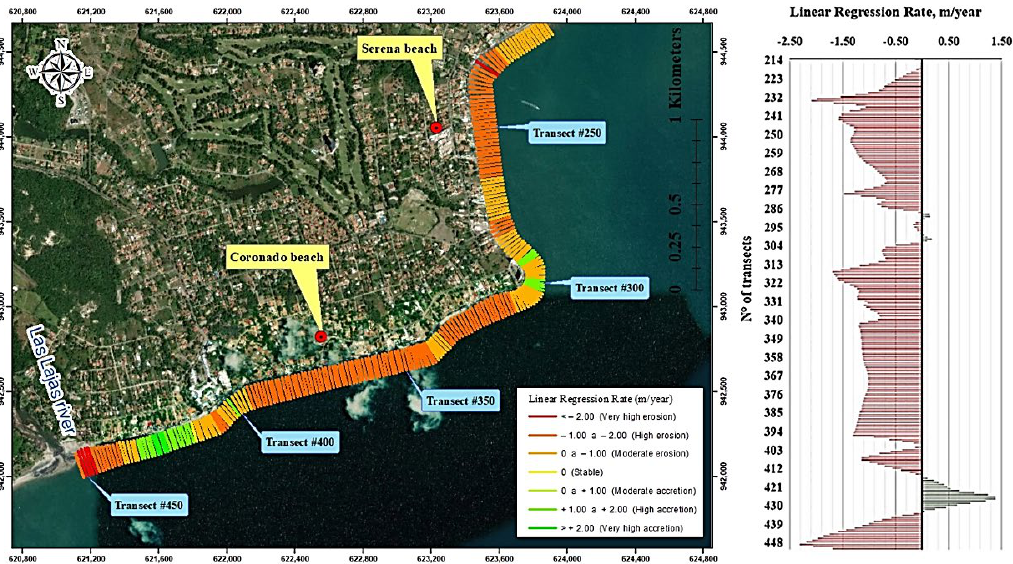
Figure 8. Erosion or accretion rates and profiles obtained by analyzing zone II by applying the Linear Regression Rate (LRR) for the period from 1998 to 2021.